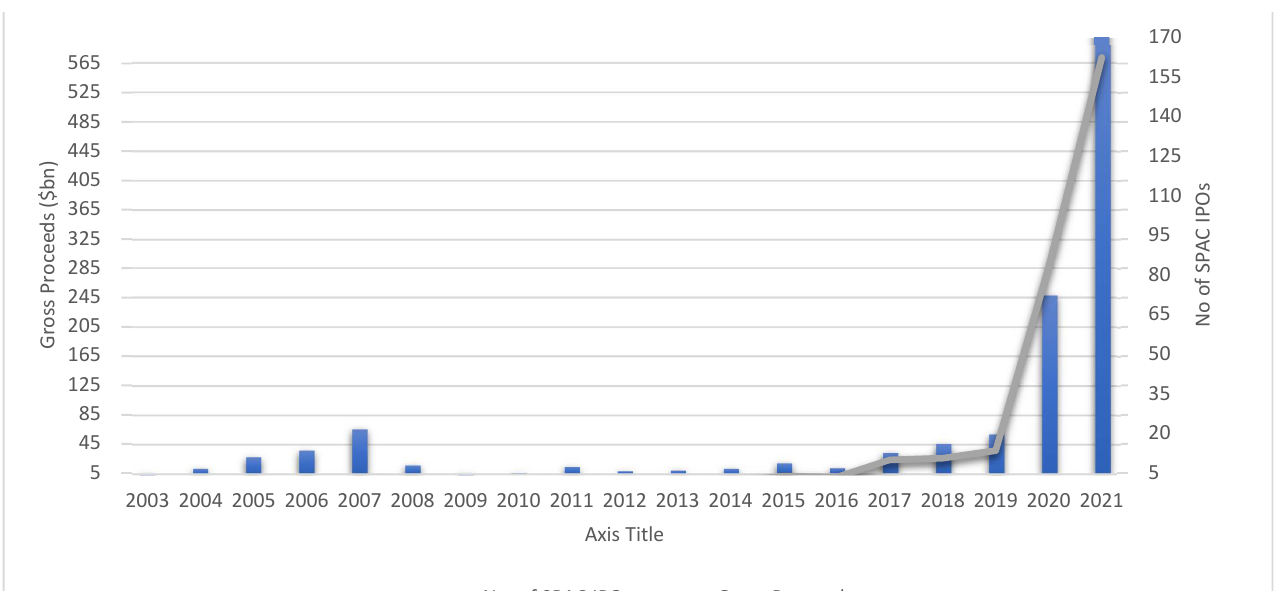
Figure 1. SPAC IPO Transactions and Gross Proceeds by Year. Source: The illustration is based on data derived from SPACInsider (https://spacinsider.com/, accessed on 15 October 2021).